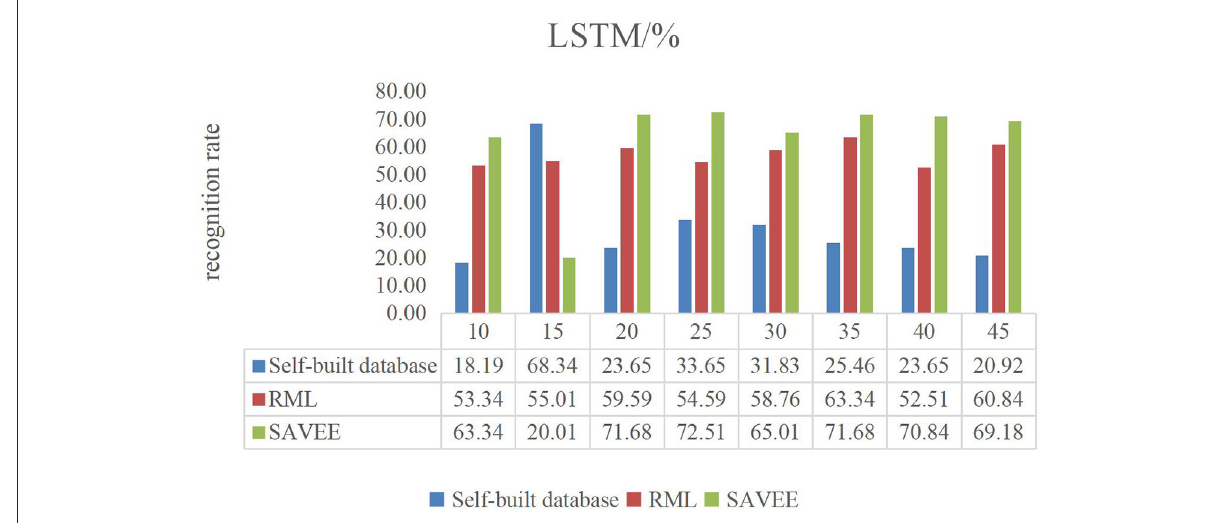
FIGURE8 LSTM dance video experiment result.